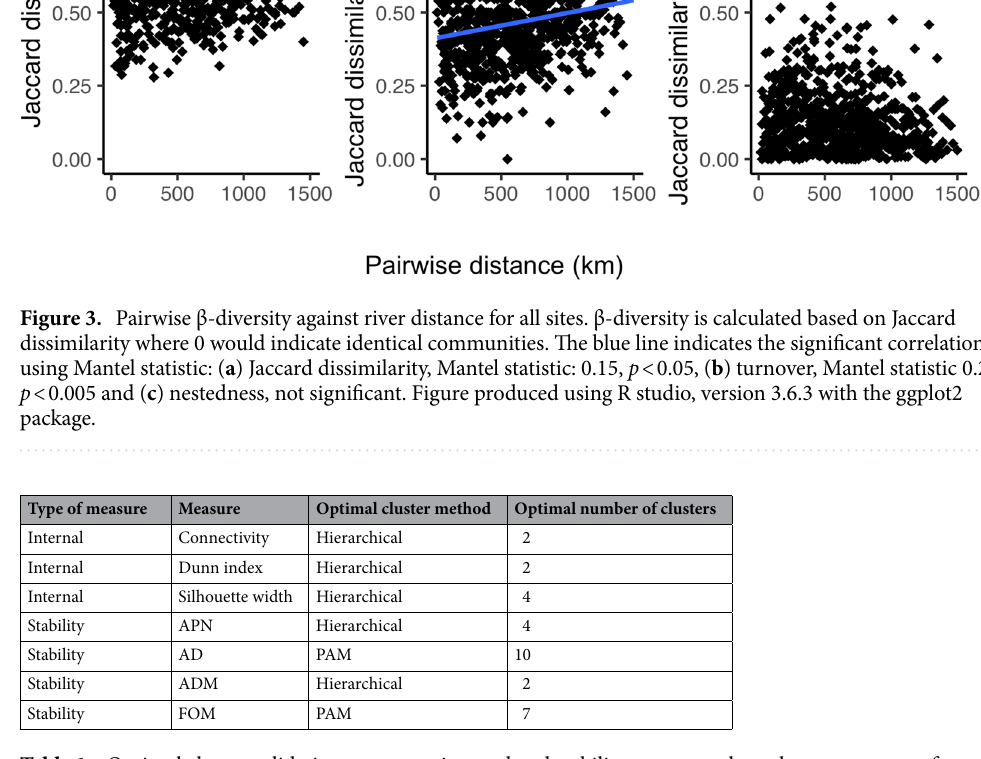
Table 1. Optimal cluster validation measures: internal and stability measures show the most support for hierarchical clustering methods (5 out of the 7 measures tested), with support for 2 and 4 clusters (see Fig. S6).